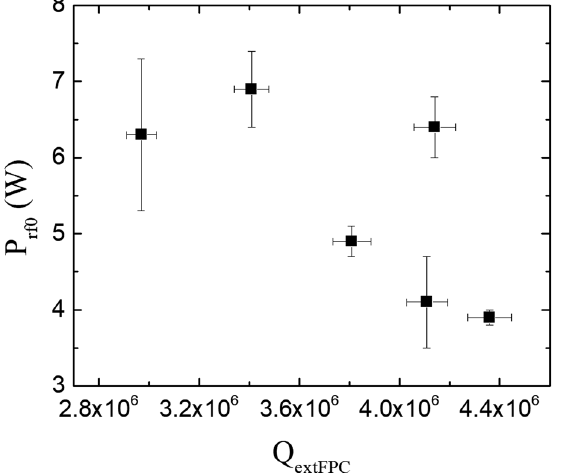
FIG. 12. The rf heat load at 2.07 K and 7 MV = m at ϕ ¼ 0 ° as a function of the Q for cavities in FEL04. extFPC